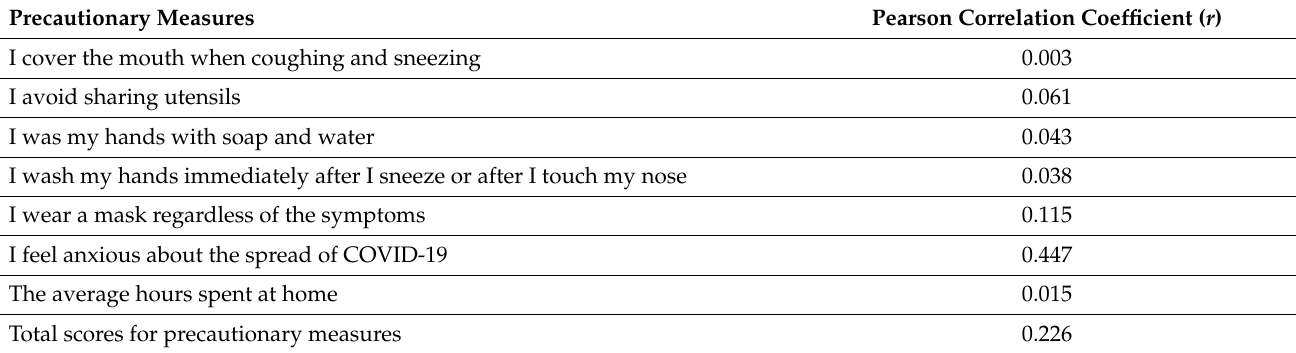
Table 5. Pearson correlation coefficient ( r ) between the precautionary measures and the CES-D score describing depression ( n = 1109, p < 0.05 when r > 0.06).